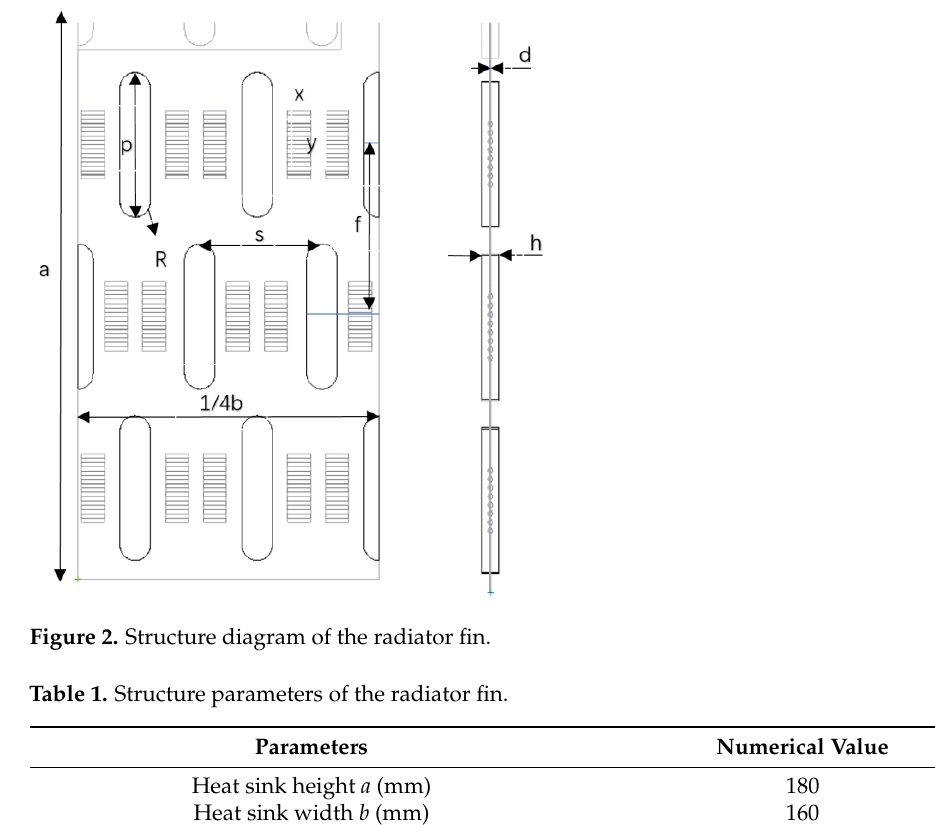
Figure 1. Diagram of the radiator fin.